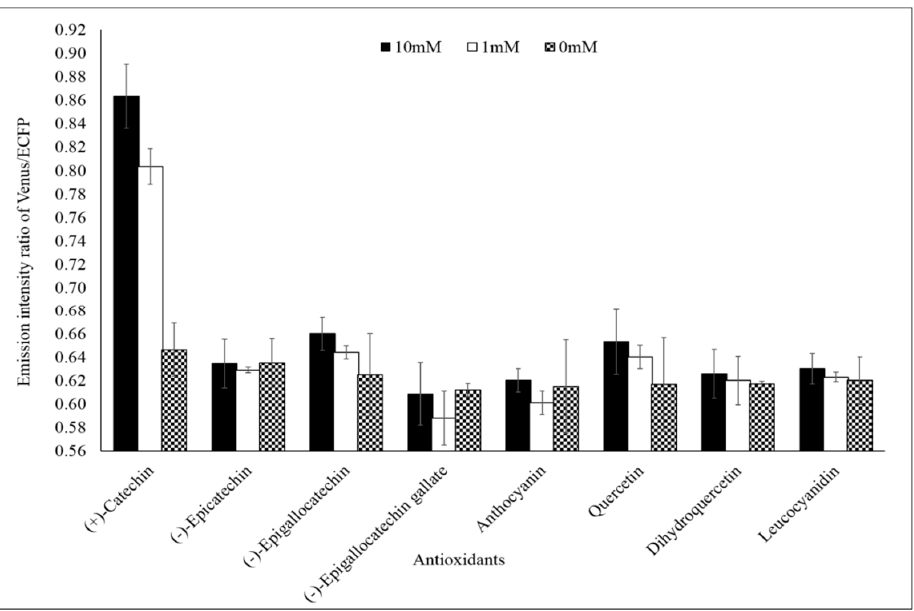
Figure 3. Specificity analysis of FLIP-Cat. Purified nanosensor protein (20 mg/mL) was taken in different wells of a microplate and various homologous metabolites of catechin (0, 1, and 10 mM) were added. In one well (+)-catechin (0, 1, and 10 mM) was added. The fluorescence resonance energy transfer (FRET) ratio was recorded. Values are the means of three independent replicate. Vertical bars show the standard error.